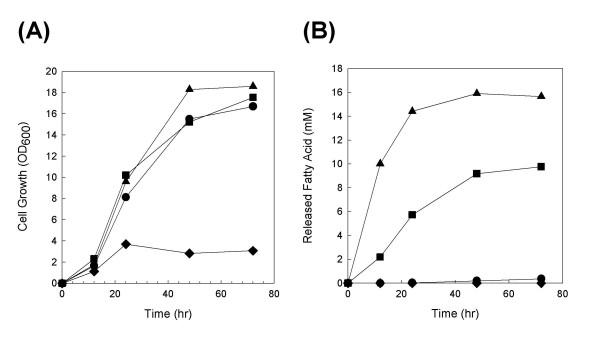
Lipid hydrolysis by surface-displayed lipase in two-phase water-isooctane fermentation system. (A) Cell growth of, (B) fatty acids released by, P. putida GM730 cells containing pRK415 (●), pJHC13 (▲), pJHC14 (■) and E. coli JM109/pJHC11 (◆).